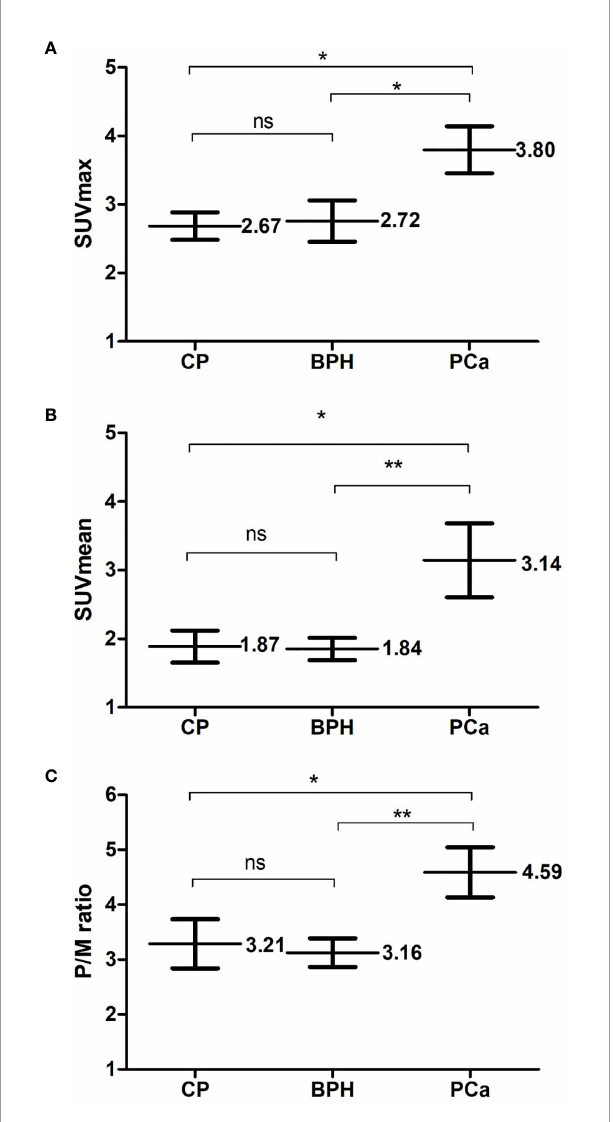
FIGURE 2 | Comparison of PCa and benign prostate hyperplasia (BPH) or chronis prostatitis (CP). Three metabolic parameters of positron emission tomography and computed tomography (PET/CT): (A) SUVmax (B) SUVmean (C) P/M ratio were respectively compared between Pca patients and patients of benign prostate diseases. Each parameter is presented as mean ± SD. NS means no signi fi cance; *means p < 0.05; **means p < 0.01.